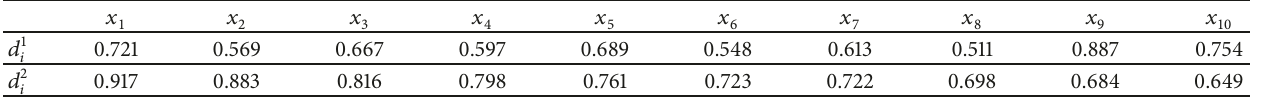
Table 7: The distance between alternative 𝑥 𝑖 and reference point under the different dimensions.